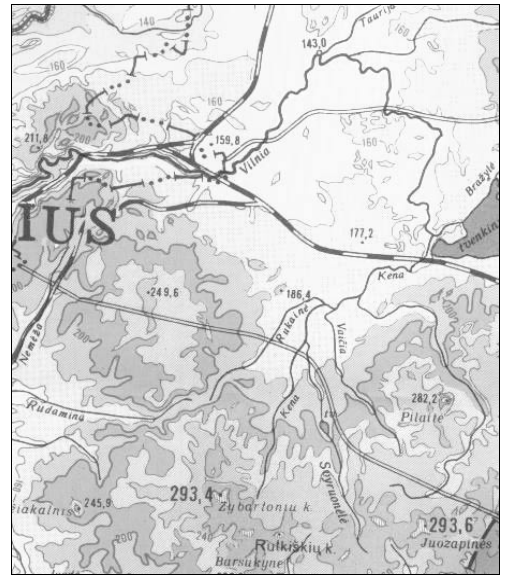
Fig 6. Fragment of relief map of Lithuania 1: 300 000.